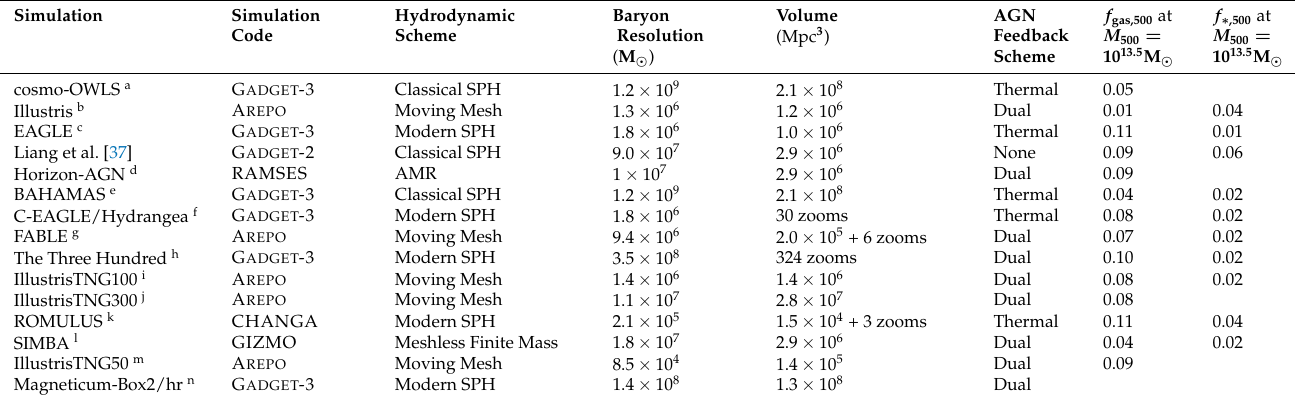
Table 1. Modern cosmological hydrodynamic simulations with groups that run to z =